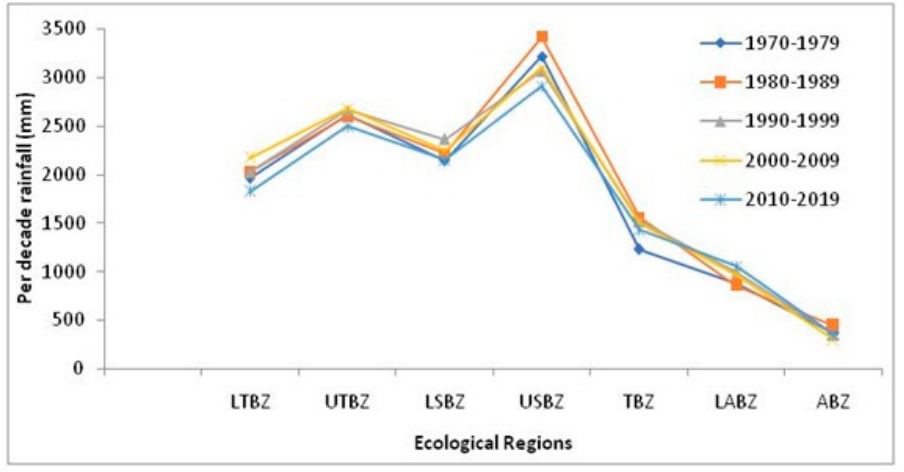
Figure 5. Decade ‐ wise precipitation trends along different bioclimatic zones in CHAL. Figure 5. Decade-wise precipitation trends along di ff erent bioclimatic zones in